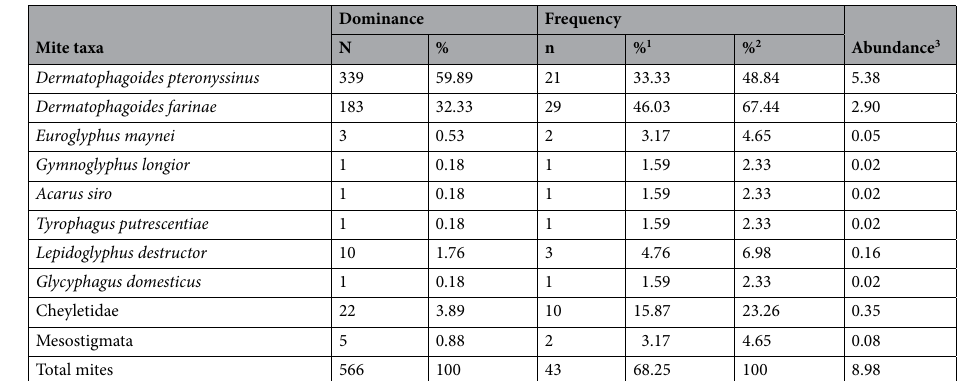
Table 1. Species list, dominance, frequency and abundance of mites found in house dust samples from dwellings of the examined asthmatic patients in Bytom (south Poland). N—number of specimens, n—number of positive samples, 1 in relation to the total of samples examined (n = 63), 2 in relation to samples positive for mites (n = 43), 3 mean number of mites per 1 sample in relation to all samples examined (n = 63).